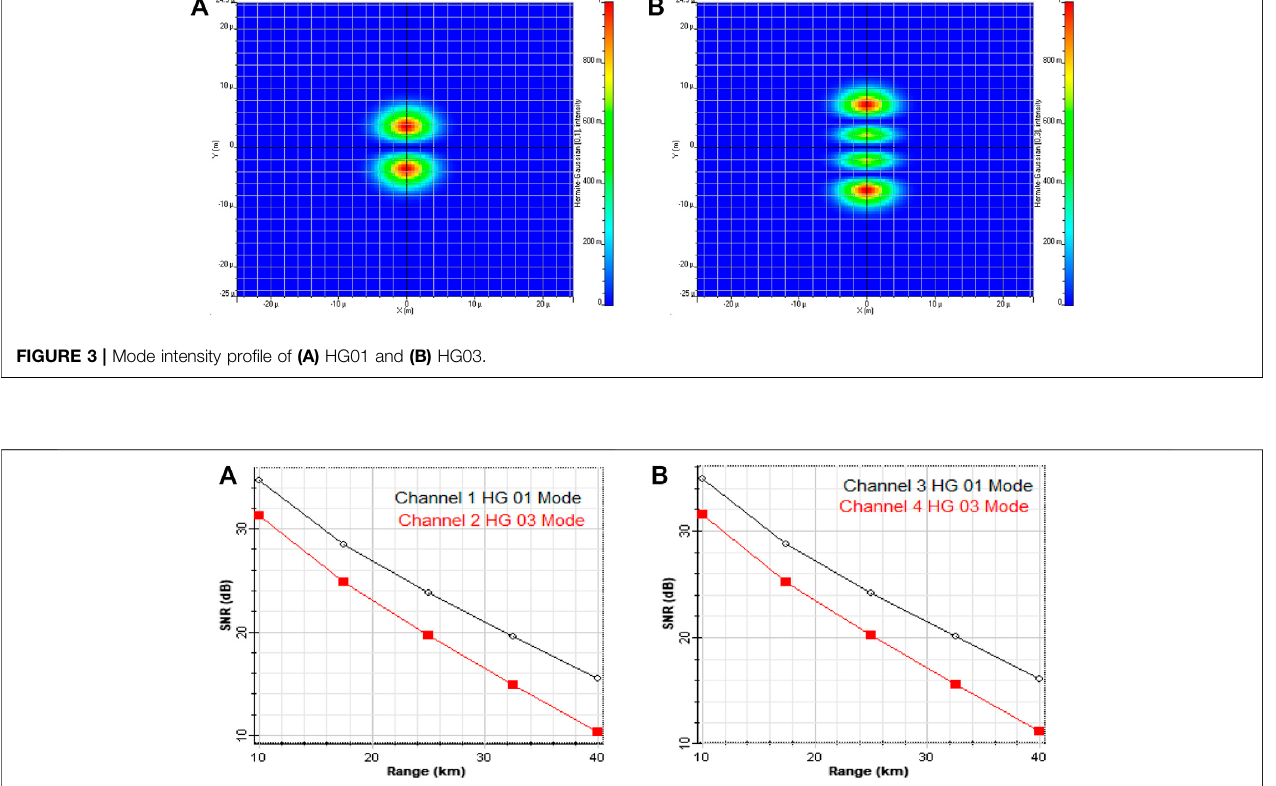
FIGURE 4 | SNR for (A) 1931. THz channel and (B) 193.2 THz channel under clear